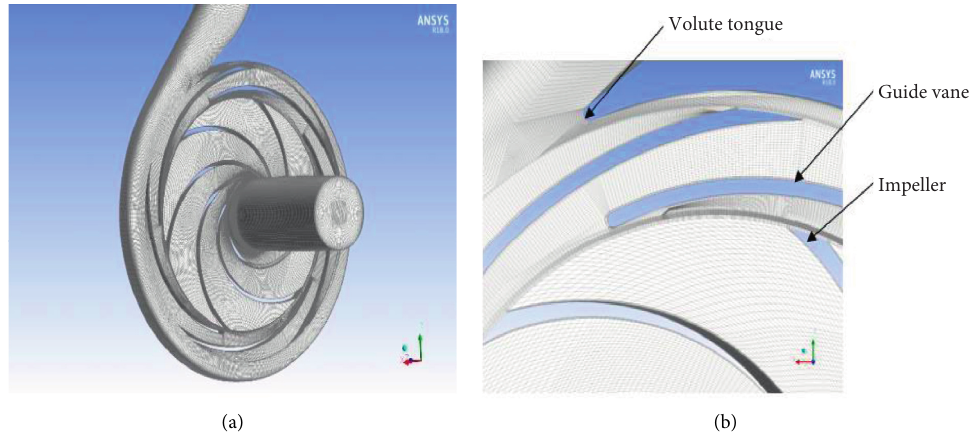
Figure 2: Mesh of the computational domain.